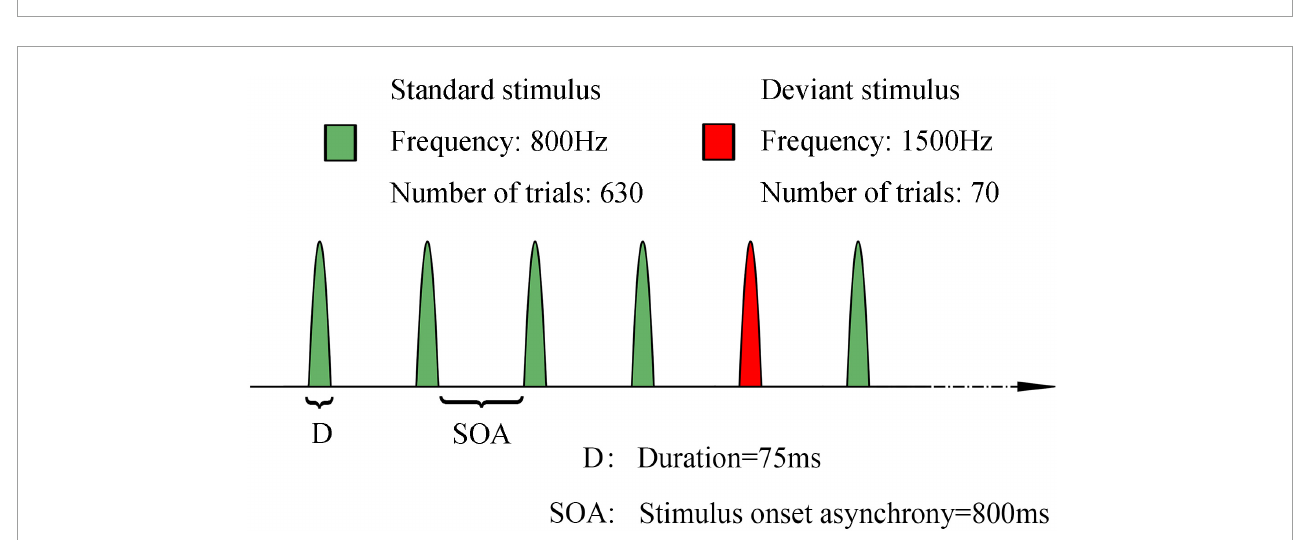
FIGURE2 Schematic representation of the stimulus paradigm of mismatch negativity. Green: standard stimuli, 800 Hz, 630 trials. Red: deviant stimuli, 1500 Hz, 70 trials. Duration of each sound stimuli is 75 ms. SOA: 800 ms. The sound stimuli were continuously and pseudorandomly presented, although there were at least three standard stimuli between two consecutive